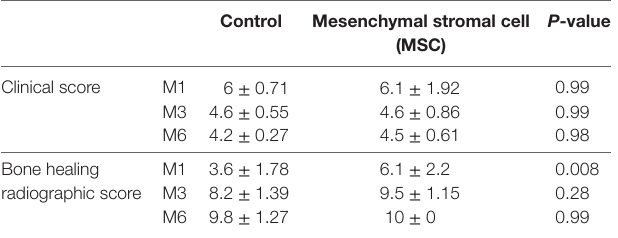
TaBlE 5 | Postoperative comparison of the clinical and bone healing scores between both groups.